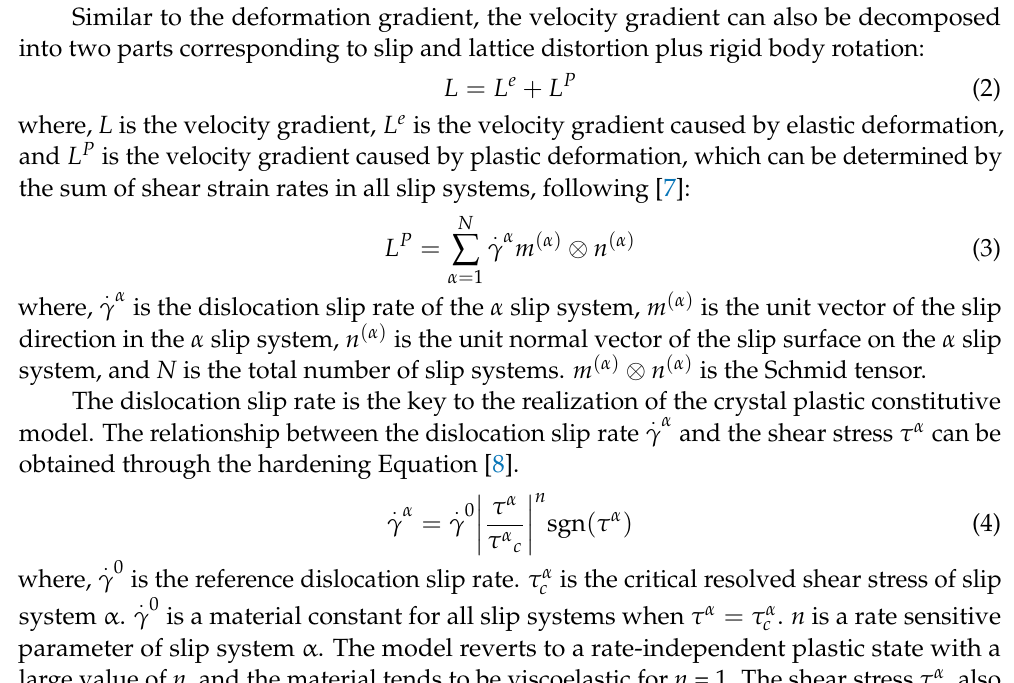
Figure 1. Grain deformation process.